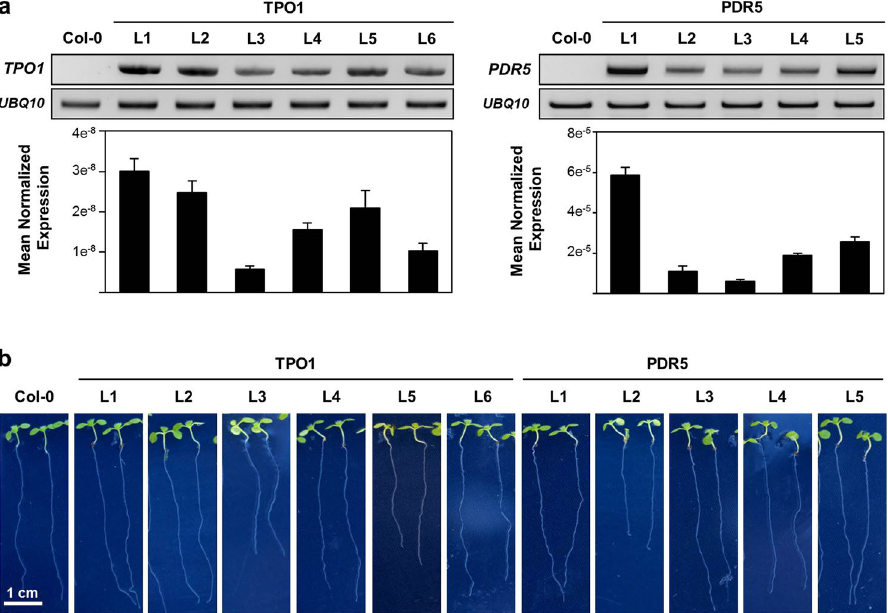
Figure 1. Transgene expression and phenotype under control conditions of transgenic Arabidopsis seedlings expressing the yeast Tpo1p or Pdr5p transporters. ( a ) Standard RT-PCR (upper panels) and real-time RT- PCR (lower panels) analysis of S. cerevisiae TPO1 (left) and PDR5 (right) transcript levels in 7-d old seedlings of the wild type (Col-0) and TPO1 (TPO1L1-L6) or PDR5 (PDR5L1-L5) transgenic lines. Expression of the UBQ10 gene was used as a loading control or as a reference gene for standard RT-PCR and real-time RT-PCR, respectively. Values represent means ± SE ( n = 4), with similar results being obtained in two independent experiments. ( b ) Representative images of 7-d old seedlings of the wild type (Col-0) and TPO1 (TPO1L1-L6) or PDR5 (PDR5L1-L5) transgenic lines grown under control